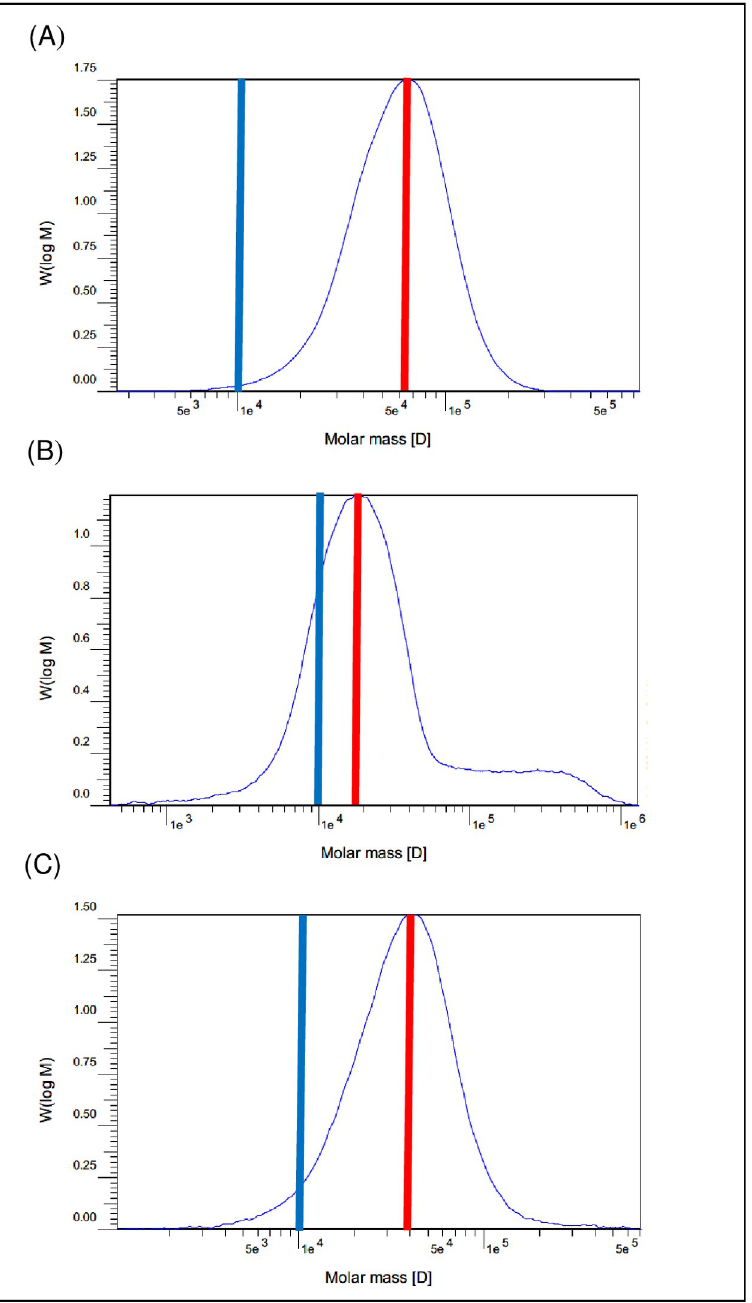
Fig 1. Beta-glucan molecular weight distribution in soluble ileal digesta from 11 d broilers fed 60% hulless barley diets in Experiment 2. Blue lines denote point 1e 4 on the x-axis and red lines indicate the Mp of the distribution curve. (A) Without medication, 0% β -glucanase (B) Without medication, 0.1% β -glucanase (C) With medication, 0% β - glucanase.